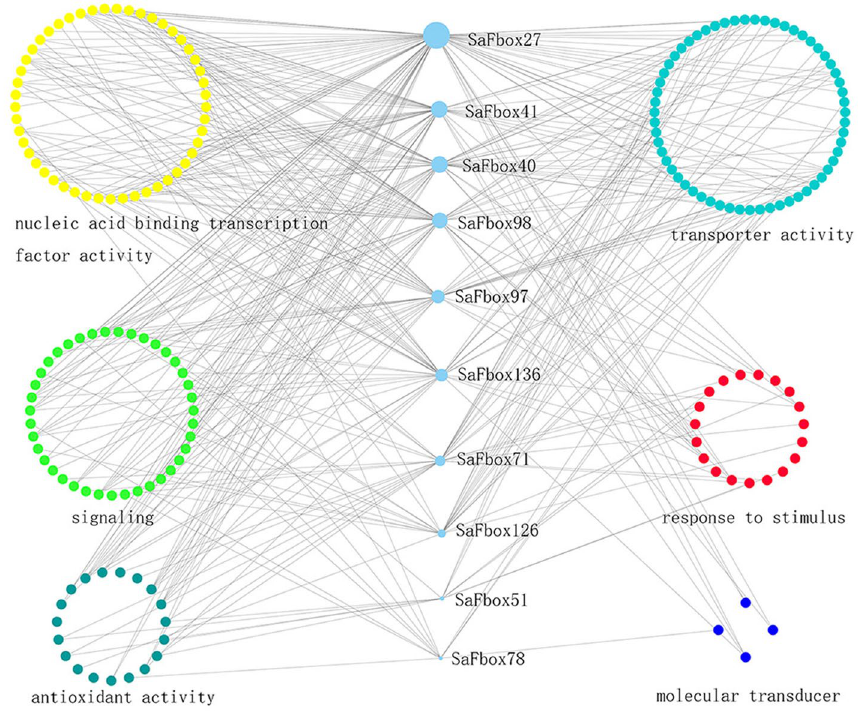
Figure 6. Co-expression network of SaFbox genes. Nodes represent individual genes and edges indicate significant co-expression between genes. Genes involved in the same biological process are grouped together distinguished by different colors.